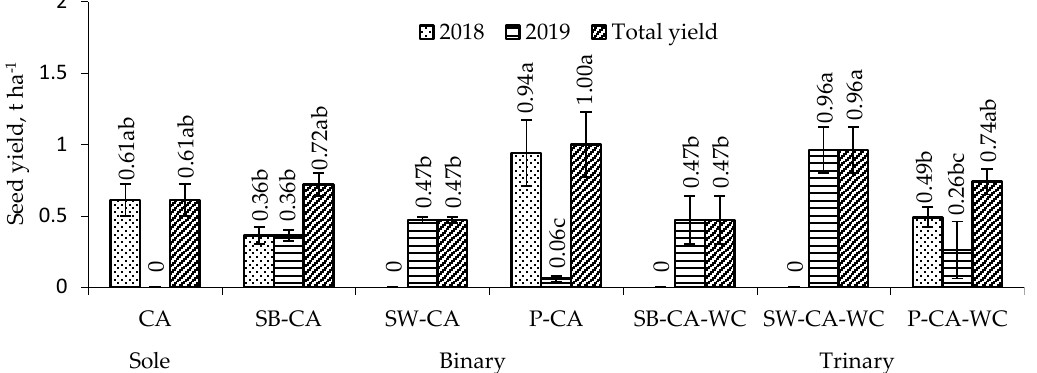
Figure 7. Caraway seed productivity, 2018–2019. Note. CA—caraway, SB—spring barley, SW—spring wheat, P—pea, WC—white clover. Differences between the averages of treatments marked with different letters (a, b, c) are significant ( p < 0.05); error bars indicate the standard error.